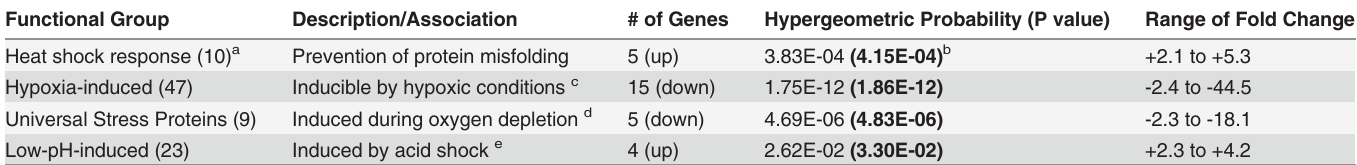
Table 5. Differentially expressed functional categories indicative of M . tb response to stress in type II AEC. Functional